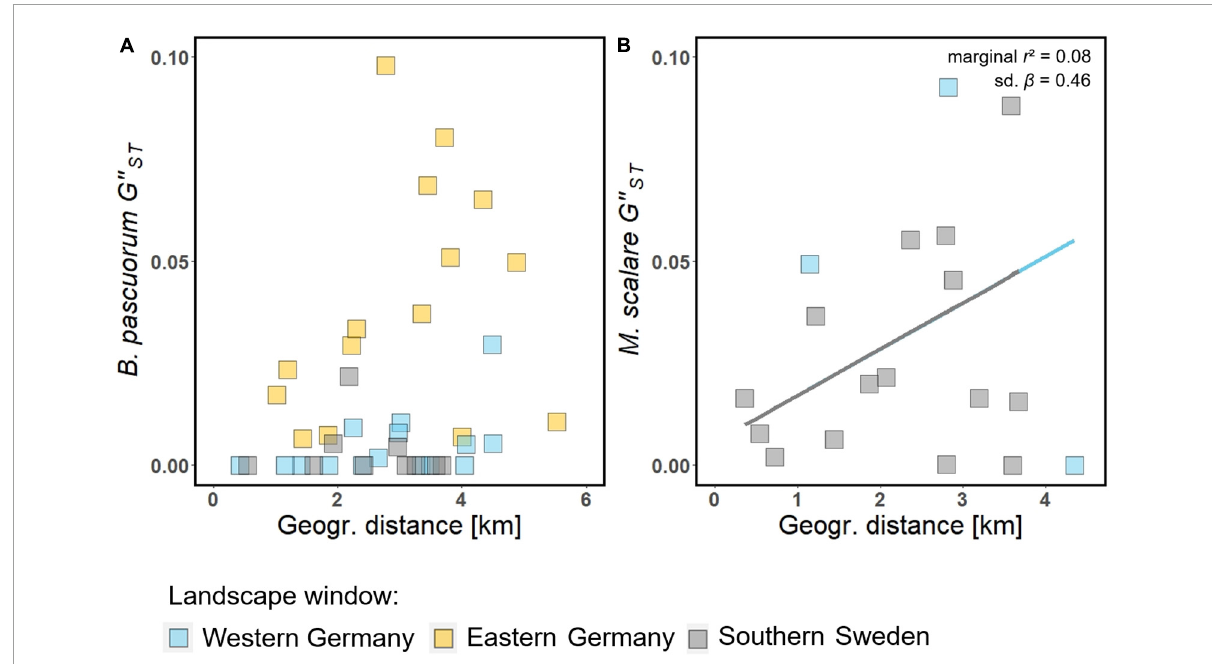
FIGURE3 Effects of geographic distance on pairwise genetic differentiation of M. scalare (B) and B. pascuorum (A) according to MLPE models. Straight lines: effects with a p < 0.05. The marginal r 2 and standardized regression coefficient (sd. β ) are shown in the upper-right part for M. scalare. Filled squares: raw